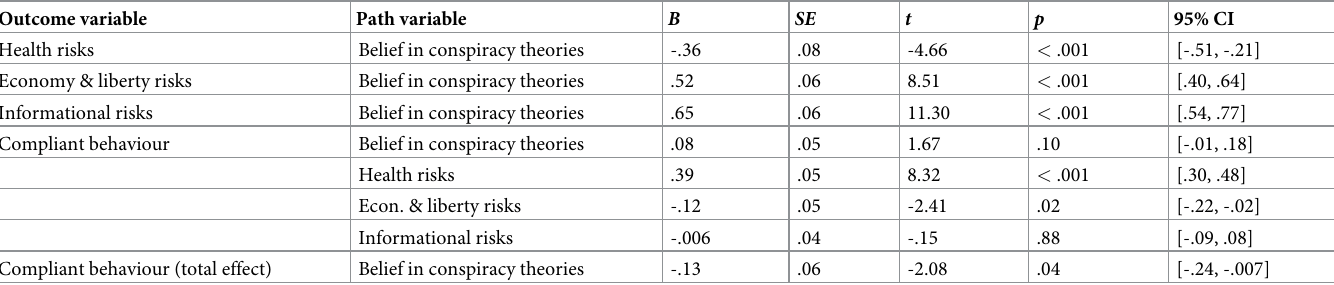
Table 4. Path coefficients.